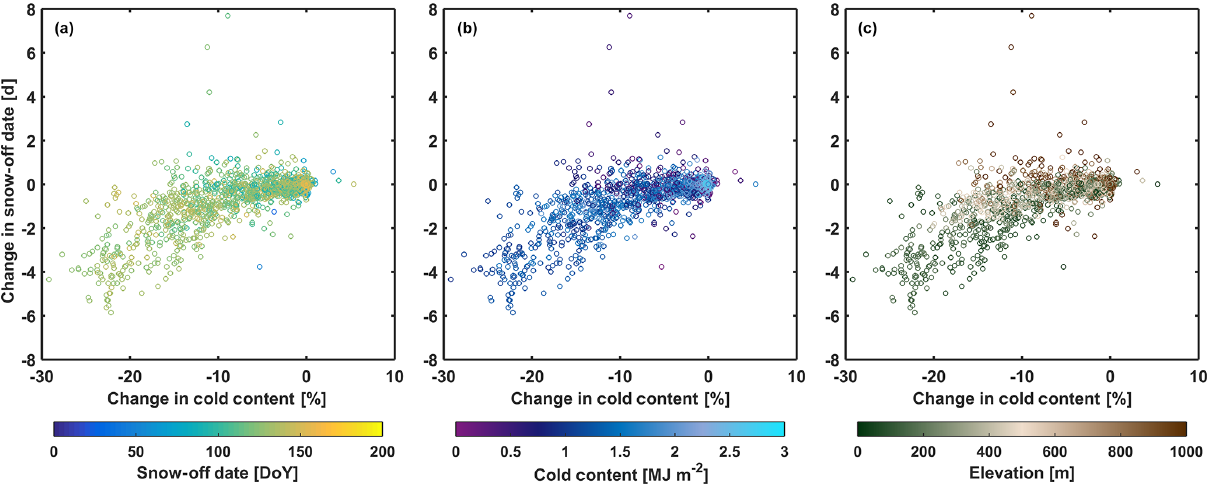
Figure 9. Change in cold content and snow-off date from CTRL to CORR as a function of (a) snow-off date and (b) cold content in CTRL as well as elevation (c) for grid cells within the area 42 to 70 ◦ N and 40 to 140 ◦